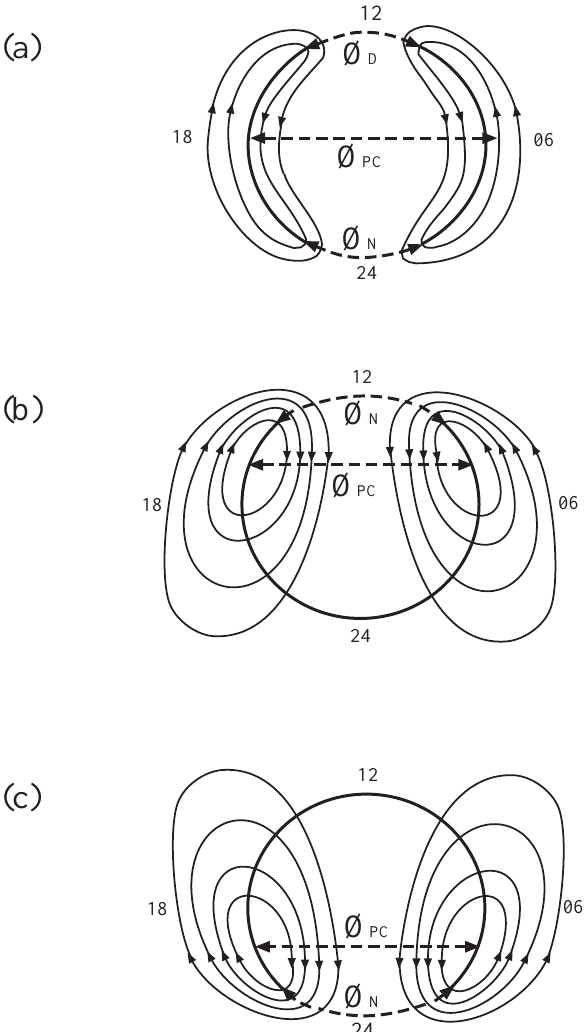
Fig. 1 Fig. 1. (a) Ionospheric convection pattern resulting from balanced reconnection at the dayside magnetopause and in the tail. (b) Con- vection generated by unbalanced dayside reconnection. (c) Convec- tion generated by unbalanced nightside reconnection (after Lock- wood,